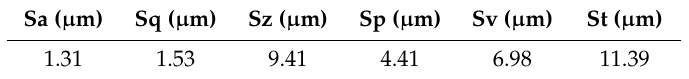
Table 2. Basic surface roughness parameters of the DDQ steel sheet